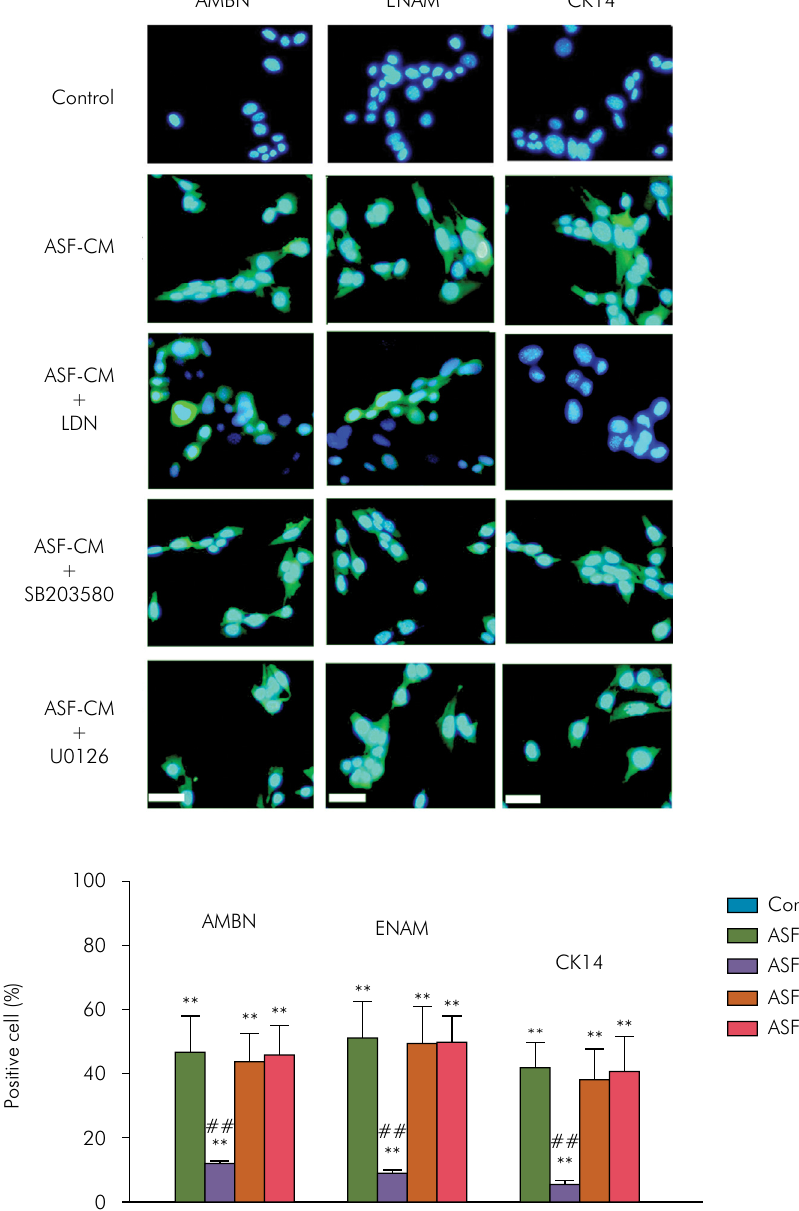
Figure 6. Immunofluorescent staining and quantification of the expression of AMBN, ENAM, and CK14 in iPS cells induced by the control medium, ASF-CM, or ASF-CM respectively supplemented with 200 nM LDN-193189 (LDN, a selective SMAD1/5 inhibitor), 10 μ M SB203580 (SB, a selective P38 inhibitor), or 10 μ M U0126 (a selective ERK1/2 inhibitor). Scale bar represents 50 μ m. **P < 0.01, vs . control group. ## P < 0.01, vs . ASF-CM